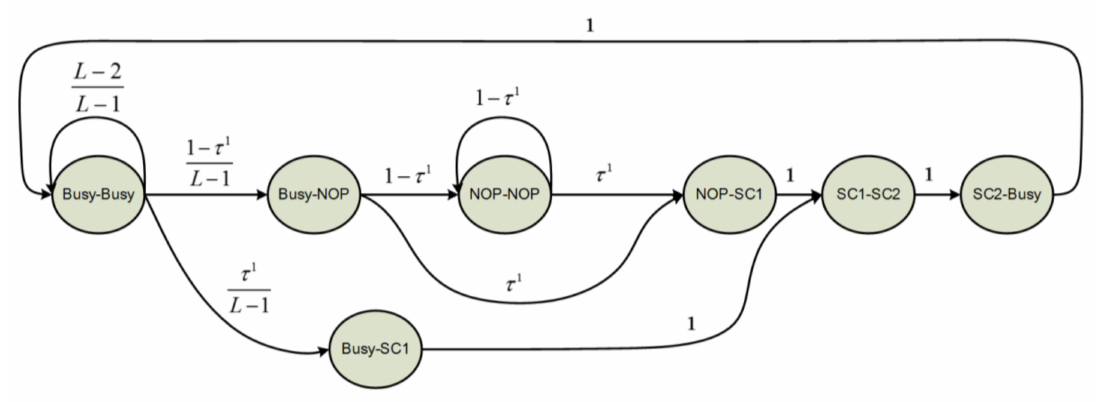
Figure 4. The proposed adjacent-slot-pair-wise channel state